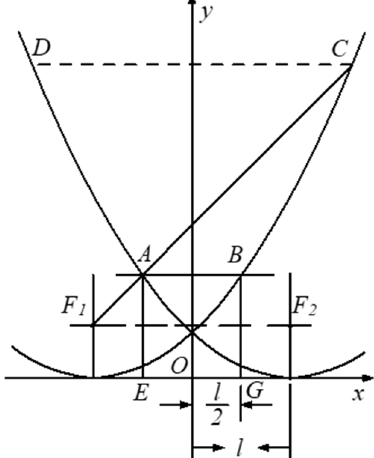
Figure A1. Schematic diagram of the concentrator.